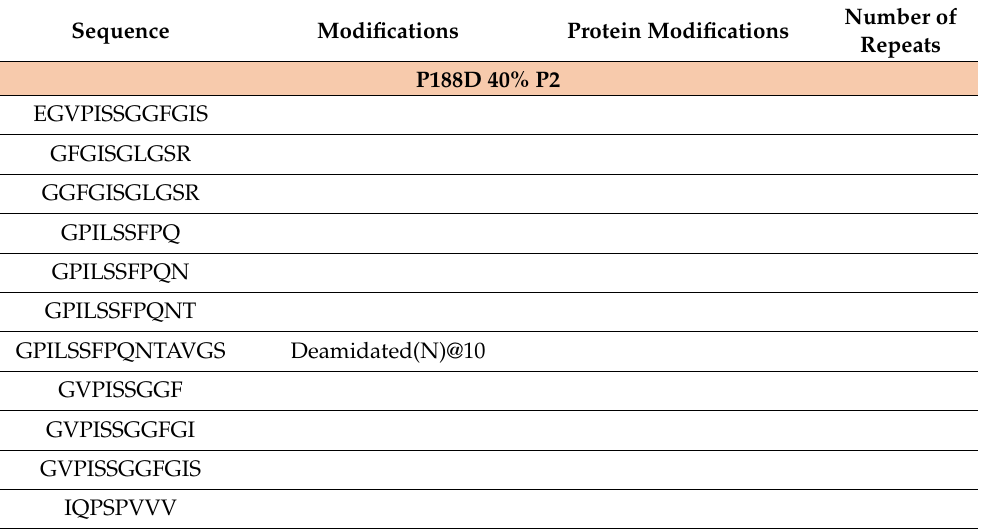
Table 6. Peptide sequence of the chicken feather microbial degradation present in the fraction P188D 40% P2 and P3 with 99 % of confidence and its homology to chicken feather keratin